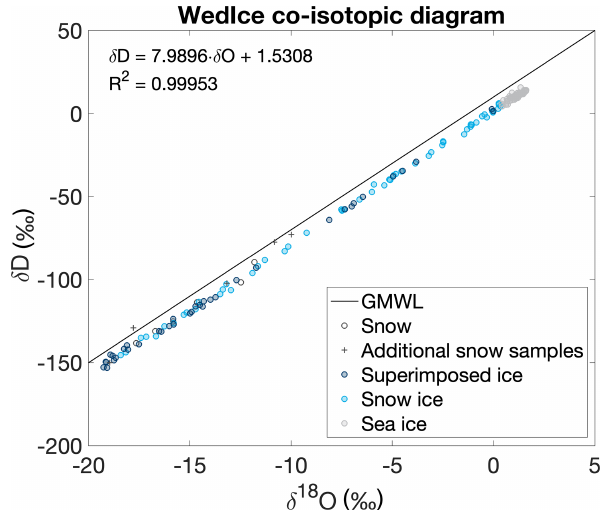
Figure C1. Oxygen isotope ( δ 18 O)–hydrogen isotope ( δD ) diagram for all WedIce samples differentiated by ice type. The global mete- oric water line (GMWL; Craig, 1961) is given for comparison. At some ice stations additional snow samples have been taken next to the ice core sampling sites which were also analyzed for isotopes and are added here with crosses ( +